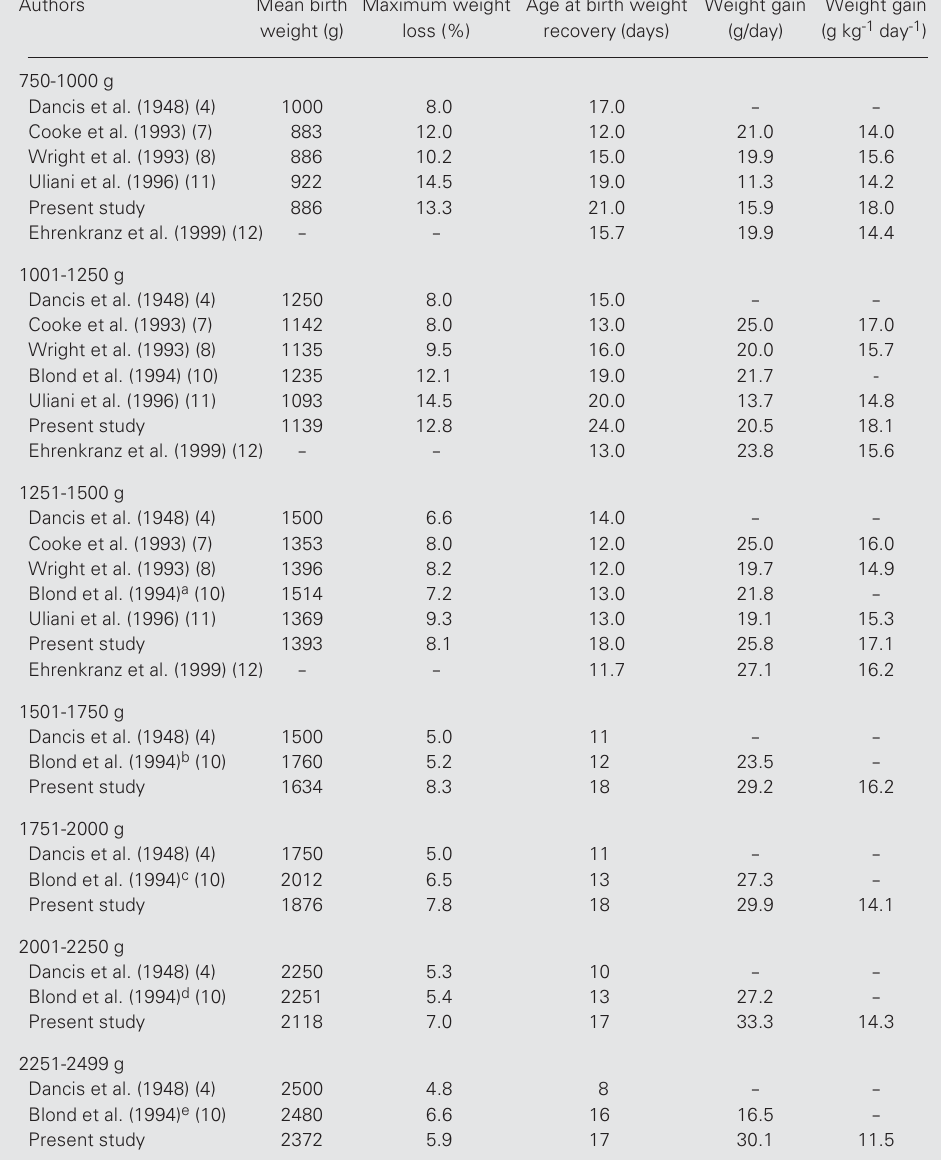
Table 2. Weight gain dynamics of preterm